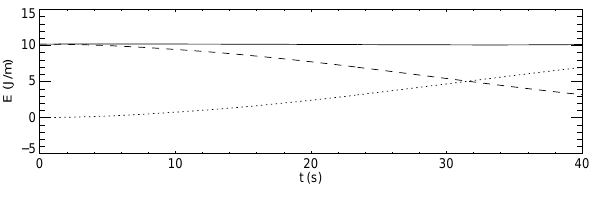
Fig. 17. Energetics for deep seiche case with a free surface. Dots: ¯ E kp . Dashed: ¯ E a . Solid: their sum.